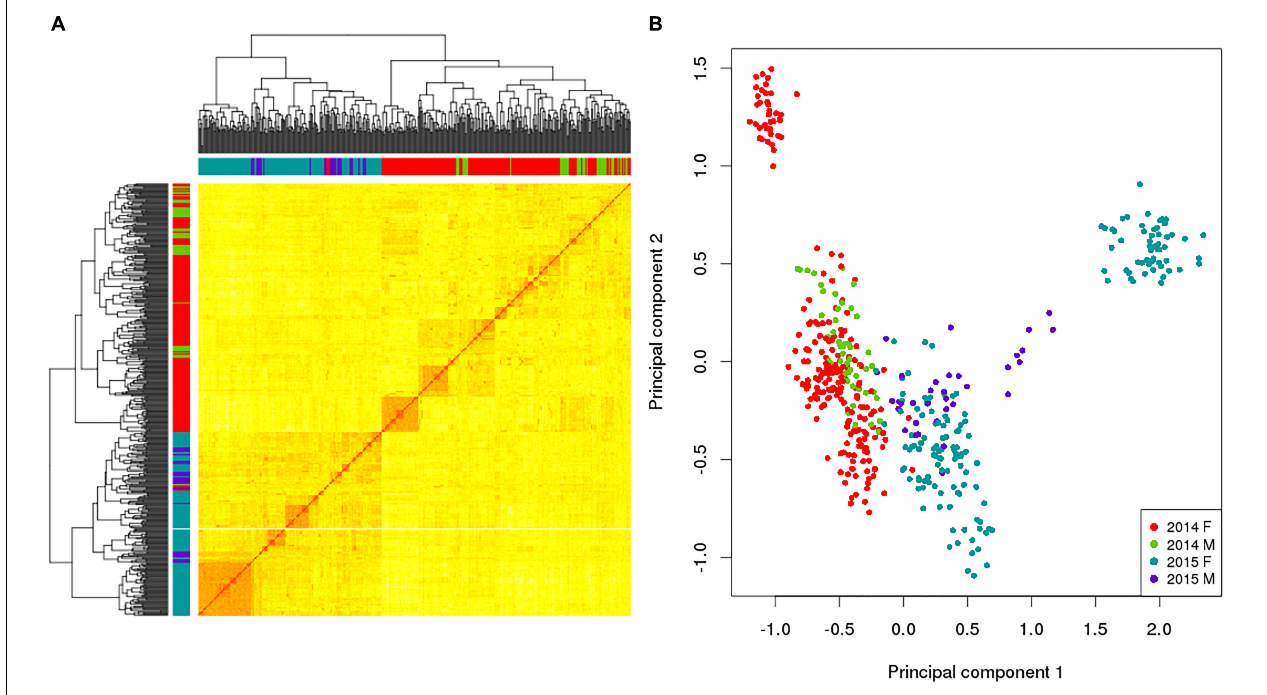
FIGURE 2 | Genomic relationship matrix (A) and principal component analysis (B) for a subset of king salmon males and females from the 2014 and 2015 year classes; self-relatedness on the diagonal and relatedness between individuals on the off diagonal. The colors in the sidebars of the GRM and the dots on the PCA refer to the broodstock group origin of the individual (Red 2014 Female, Green 2014 Males, Blue 2015 Female and Purple 2015 Male). For the GRM the darker (and redder) the color in the matrix, the more related the individuals. The PCA explains 23.6% in the first component and 9.5% in the